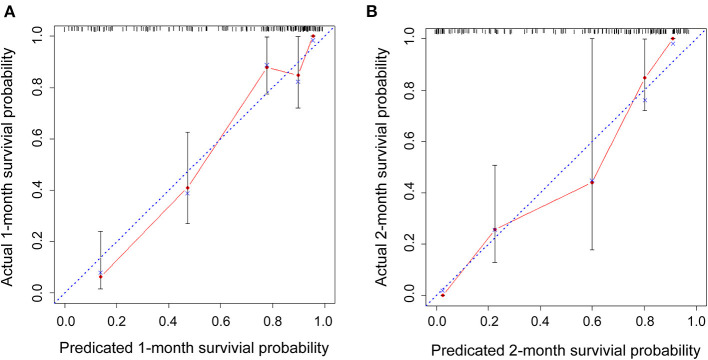
Internal cross-validation calibration curves at 1 and 2 months. (A,B) Internal cross-validation calibration plots at 1 and 2 months.